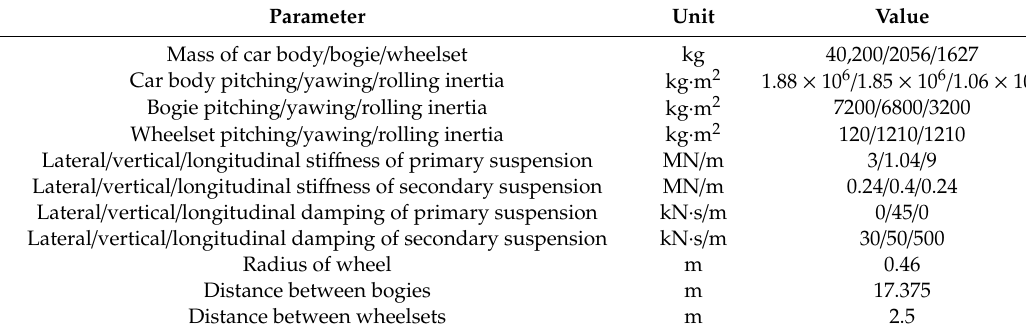
Table 1. The parameters of the CRH3 vehicle.